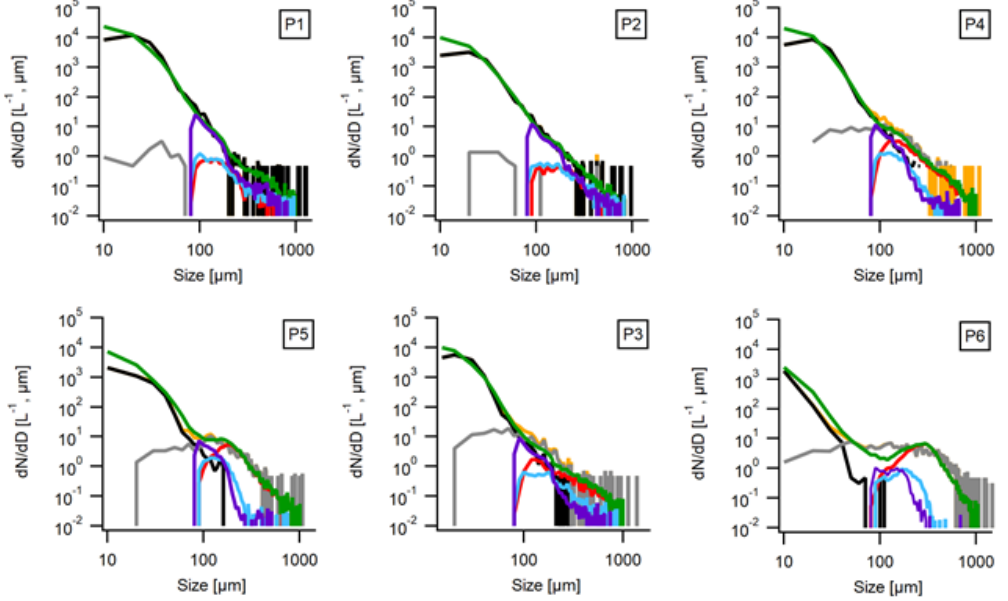
Figure 8. Particle size distributions for the 2DS: all particles (green line), low irregular (purple line), medium irregular (light blue line), and high irregular (red line) according to the characterised categories, and HALOHolo spherical (black line) and irregular particles (grey line)